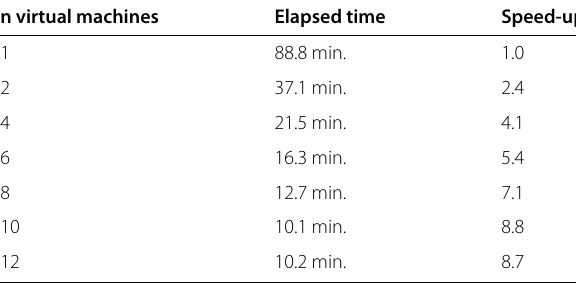
Table 5 Run time results of our optimisation workflow